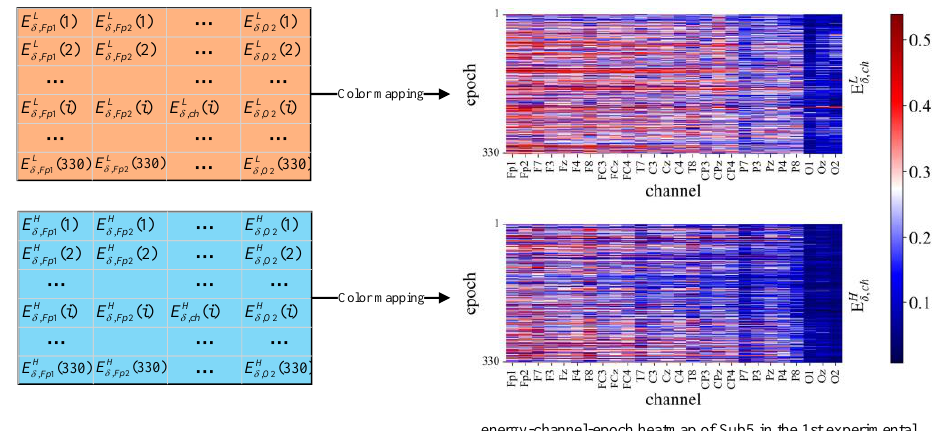
Figure 2. Energy – channel – epoch heatmap drawing flow. In the energy–channel–epoch heatmap, the y -axis on the left represents epochs in chronological order, the x -axis at the bottom corresponds to 26 EEG channels, and the y -axis color palette on the right visualizes the EEG energy with a color gradient and the color palette. Same rhythm energy values in low and high MW levels, E L, are plotted together to compare directly. It is similar to the visualization process of the other three EEG rhythm energy. Observational analysis of heatmaps lay the foundation for sensitive selection, and we built a mathematical method to implement this process rather than